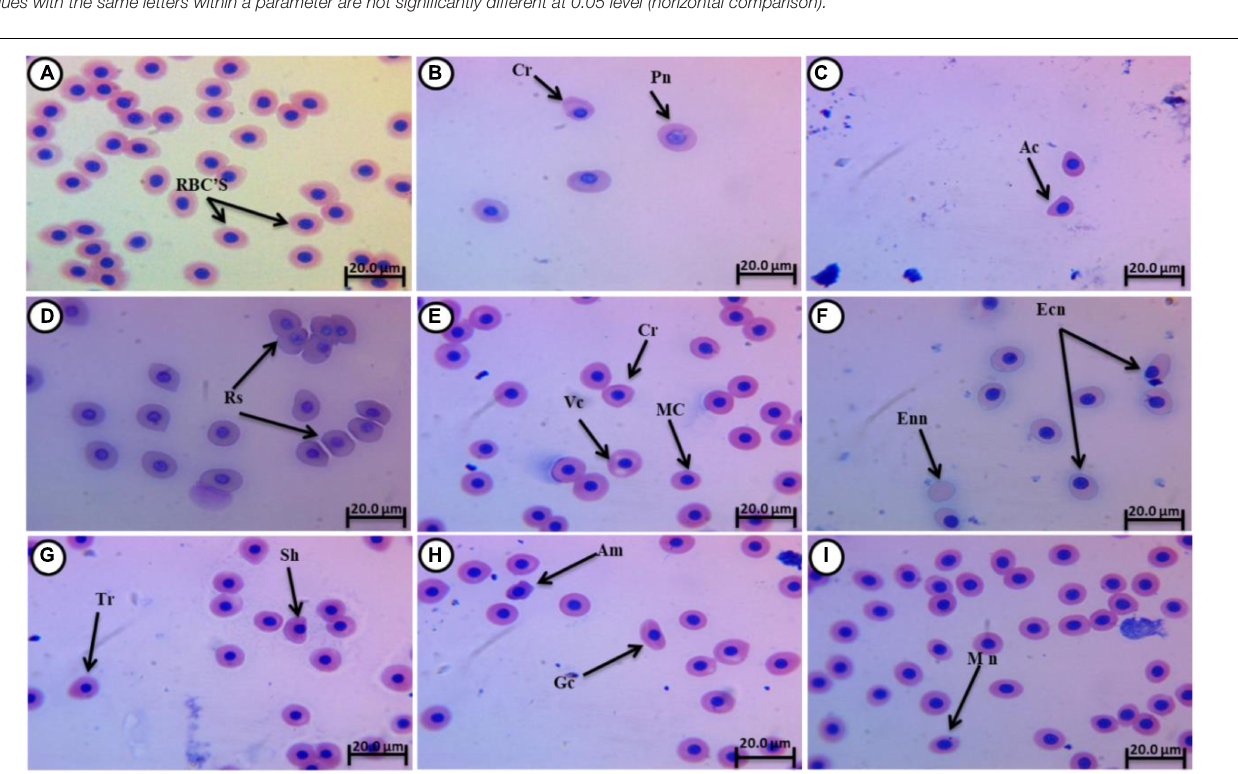
( P < 0.01) between the treatment groups and the control group were recorded in all erythrocyte parameters except in Table 4